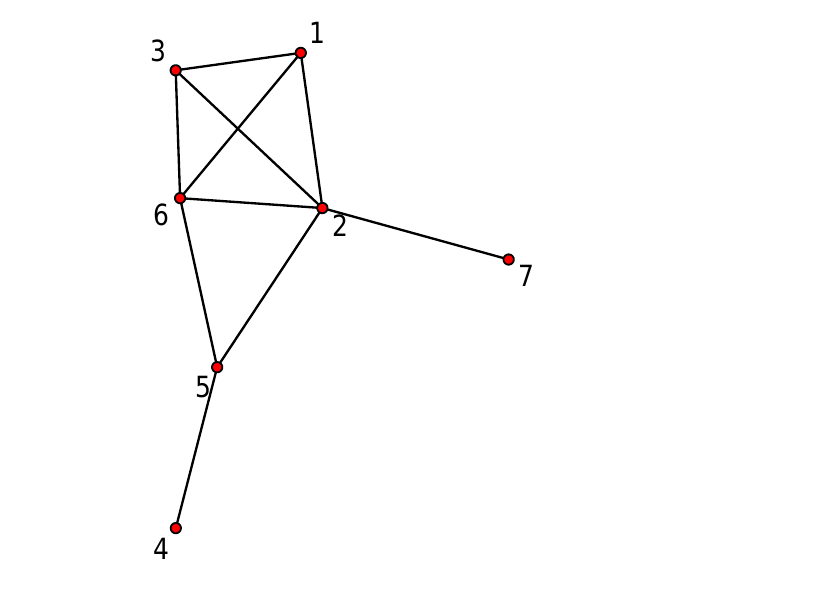
Figure 1. An example of a network on 7 nodes. The nodes are the red dots, labelled 1 to 7 and represent individuals in the population. The edges are shown as black lines connecting the nodes and represent possible routes of transmission. The degree of each node is number of edges adjacent to it, so that node 5 has degree 3 and node 7 has degree 1. The degree sequence of the network is the count of nodes with a given degree and can be represented by the vector (0 , 2 , 0 , 3 , 1 , 1) showing that there are 0 nodes of degree 0, 2 of degree 1, 0 of degree 2 and so on. A cycle in the network is a path starting at a node and following distinct edges to end up back at the same node. For example, the path from node 6 to node 1 to node 3 and back to node 6 is a cycle but there is no cycle that includes node 4. Clustering is a measure of propensity of cycles of length 3 ( triangles ) to form. Here, the edges (2,1) and (2,6) form a triangle with the edge (1,6), so work to increase clustering in the network. However, the edges (2,1) and (2,5) do not comprise part of a triangle as (1,5) does not exist, so work to decrease